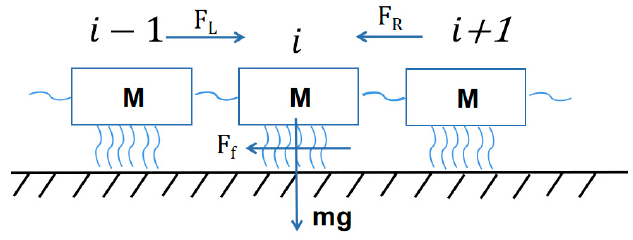
Figure 7. Concrete surface friction spring slider model.